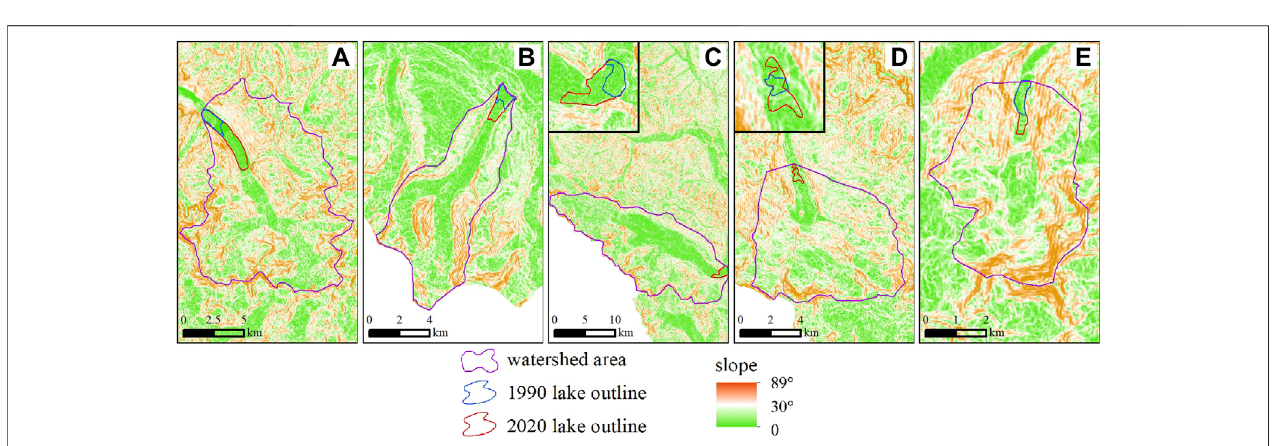
FIGURE 9 | Examples of dangerous glacial lakes in the YZRB: (A) Jiongpu Co., (B) Shimo Co., (C) Laigu Co., (D) Guangxie Co., (E) Jiweng Co.